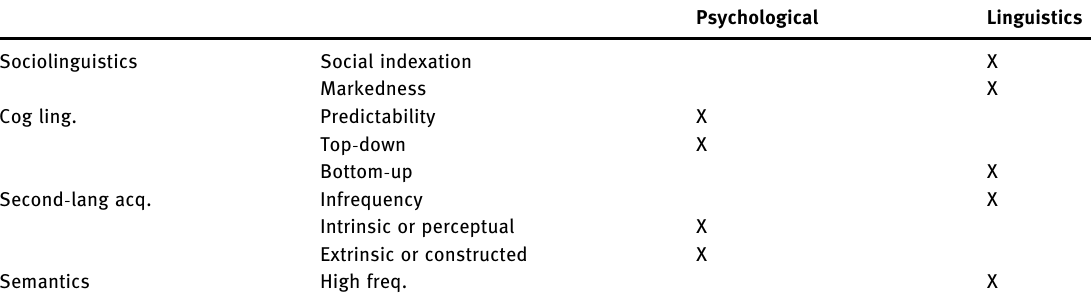
Table 1: De fi nitions per sub -